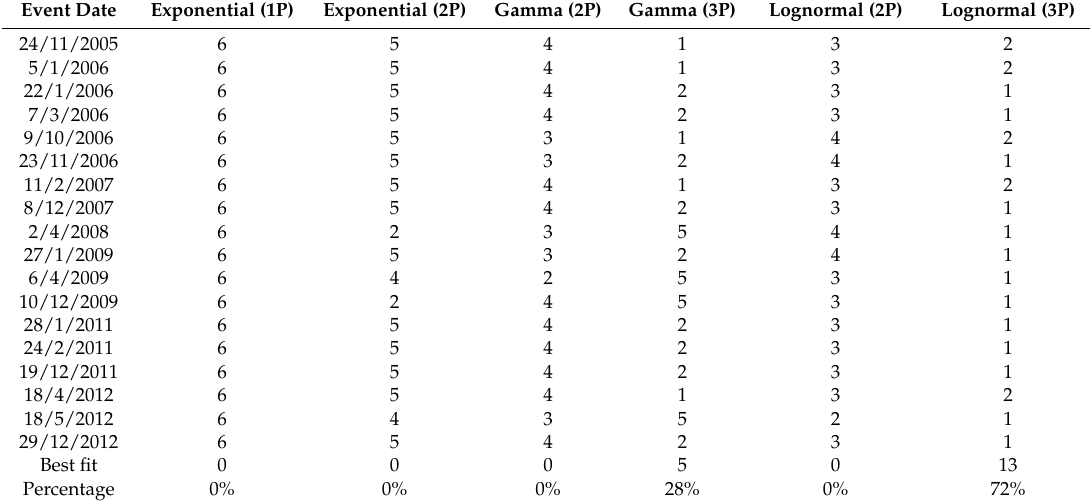
Table 3. Best fit for stratiform events.